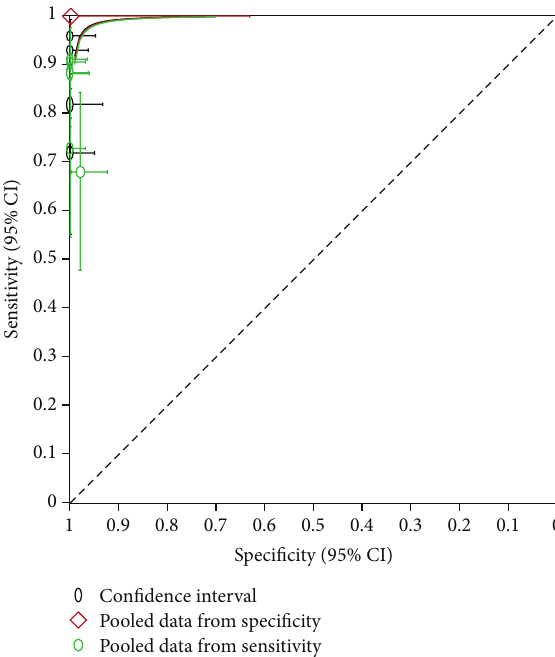
Figure 4: SROC from all included studies.